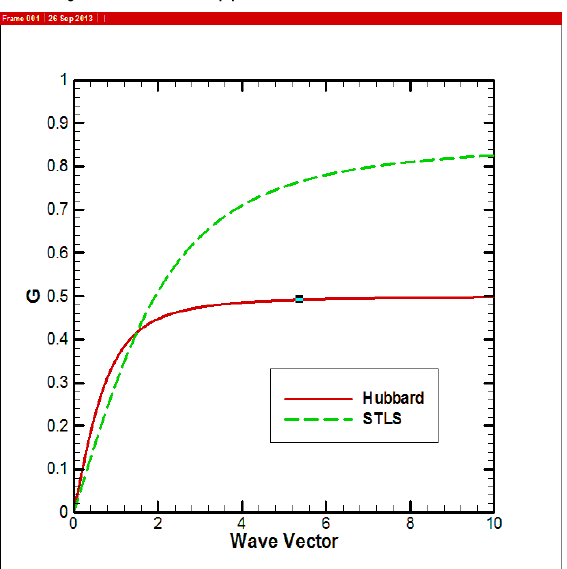
Fig. 2. Real Part of dynamic dielectric function of single nanolayer within all approximations.